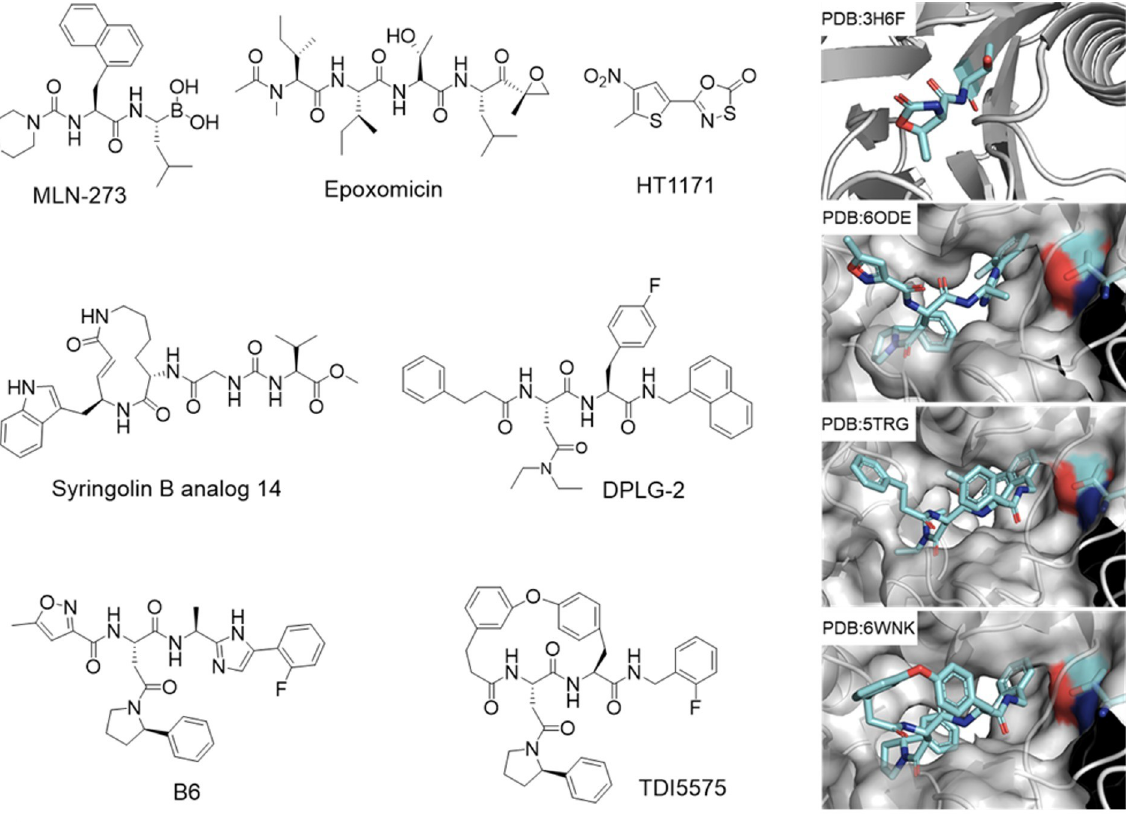
Fig 3. Proteasome inhibitors tested for species selectivity of inhibition of Mtb20S. MLN-273 and epoxomicin were first tested during the discovery of the role that the Mtb20S plays in the defense of Mtb against nitrosative stress. HT1171 and GL5 are irreversible inhibitors discovered in a high-throughput screening campaign. Syringolin B analog 14 is an irreversible inhibitor developed based on the natural product syringolin B. DPLG-2, B6, and TDI5575 are noncovalent reversible inhibitors that are highly selective for Mtb20S over human proteasomes.